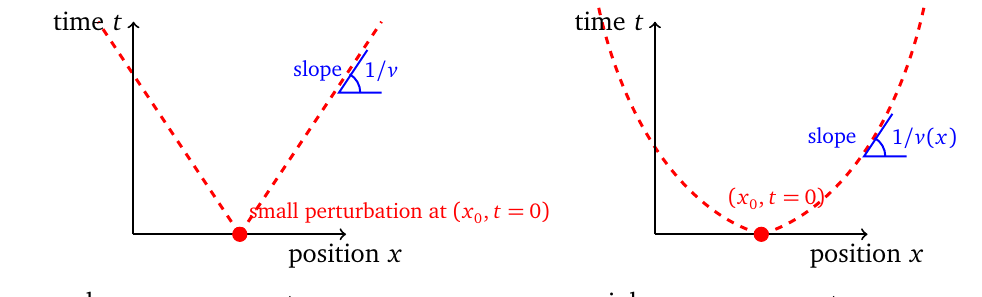
Figure 1: Cartoon of the phenomenon investigated in this paper. (Left) When one applies a small perturbation to a Luttinger liquid at position x and at time t = 0, the signal generated 0 ± vt . by the perturbation propagates along the left- and right-arms of the light-cone, x = x 0 (Right) in an inhomogeneous system, the velocity v of gapless excitations becomes a function of position, and, as a result, the propagation of gapless excitation is along curved light-cones. The goal of this paper is to confirm the emergence of such curved light cones in some concrete microscopic